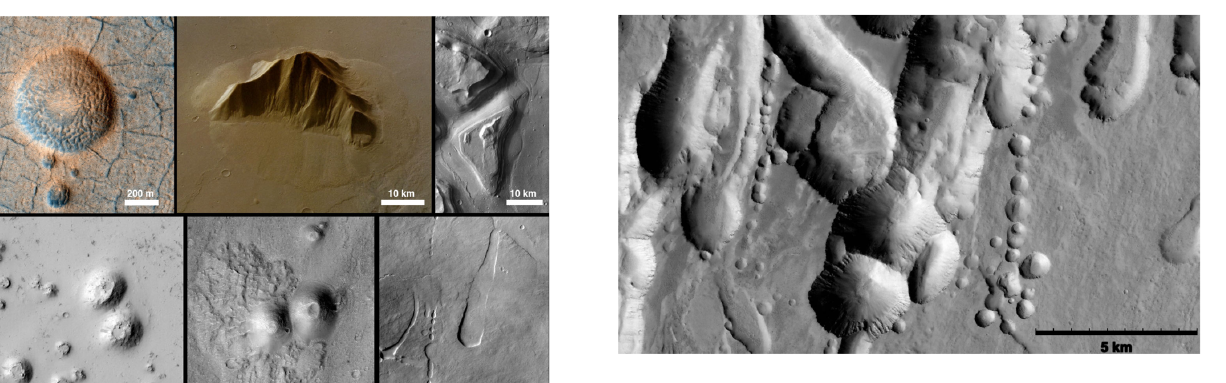
Fig. 6. Potential primary target for muon radiography exploration on Mars. Complex terrain of collapse structures on the lower flanks of Arsia Mons, Mars likely contains lava tubes and caves in the sub- surface (Cushing et al., 2007; Williams et al., 2010). Muon radio- graphy obtained from trough floors could be used to map the void space associated with partially collapsed lava tubes. High-resolution digital topography data can be used to delineate the 3-D geometry of the candidate targets including possible observation vantage